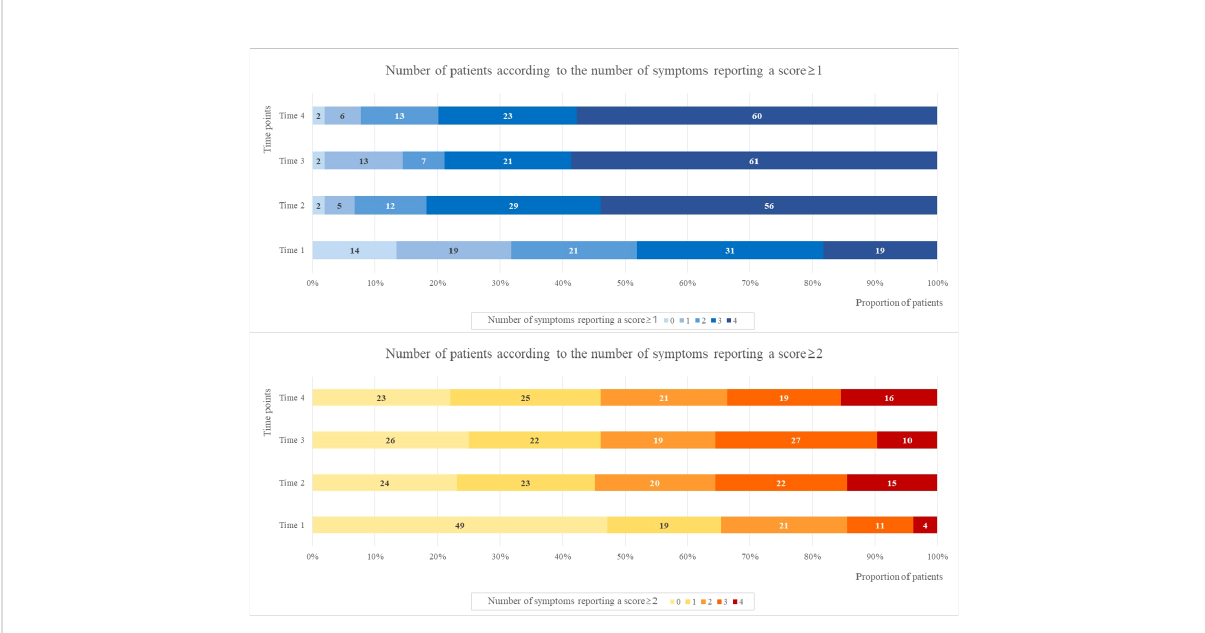
FIGURE 2 The number of patients according to the number of symptoms reporting a score ≥ 1 and ≥ 2 at four time